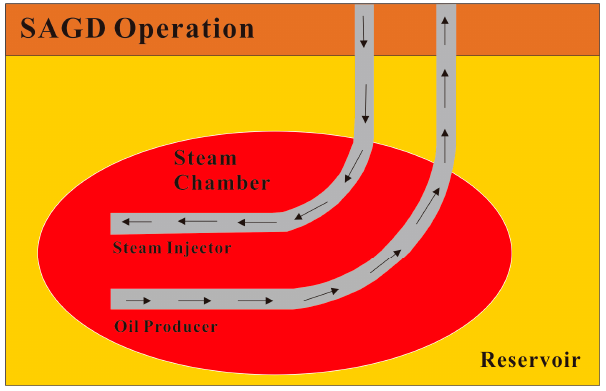
Figure 1. Scheme of SAGD Operation.